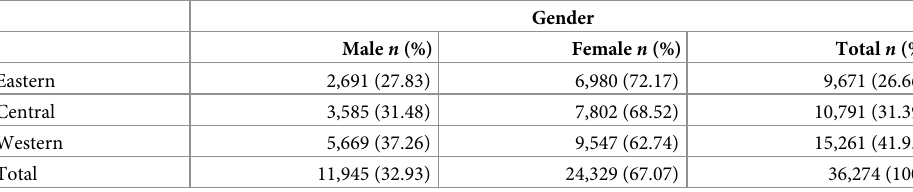
Table 4. Distribution of the teachers by geographical region and